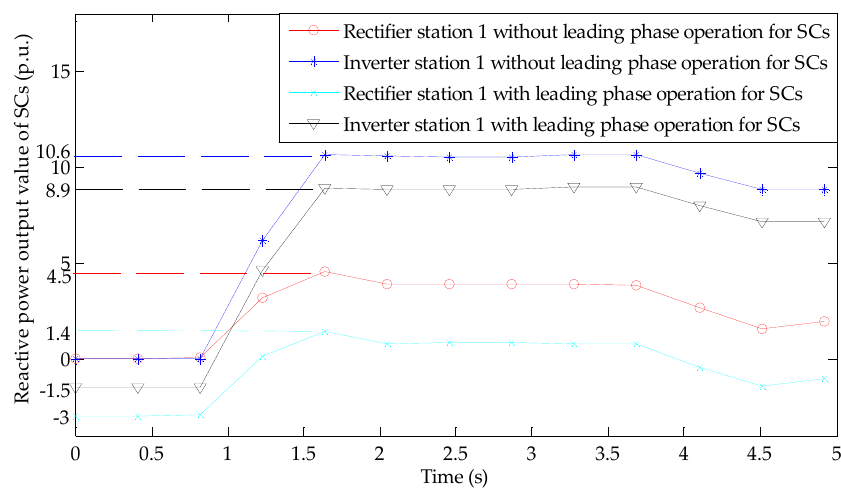
Figure 4. Effectiveness of the leading phase operation for SCs installed close to converter stations of HVDC Link 1.